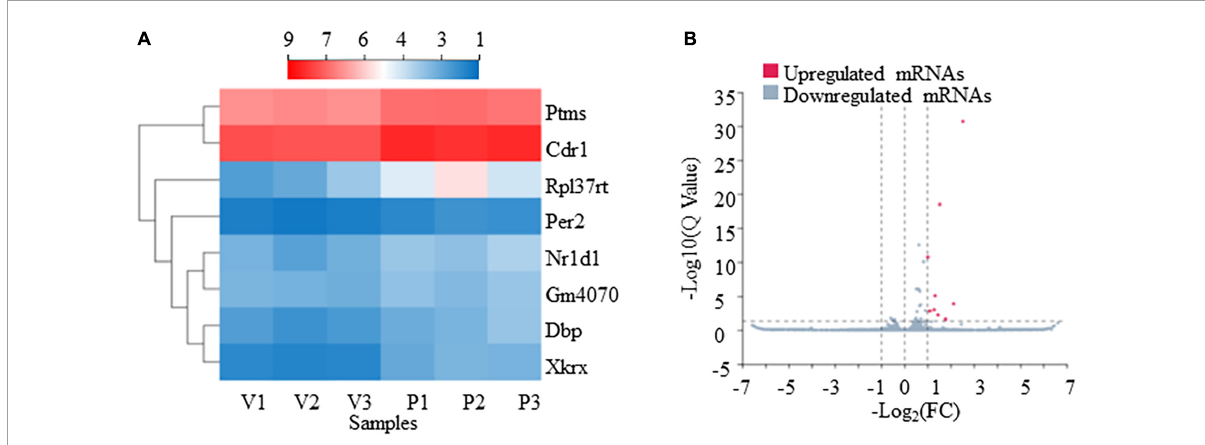
FIGURE5 Transcriptome profiling of mRNAs in paclitaxel (PTX)-treated mice. (A) Hierarchical clustering analysis revealed eight differentially expressed mRNAs in vehicle and PTX groups. (B) Volcano plot of differentially expressed mRNAs following PTX administration.